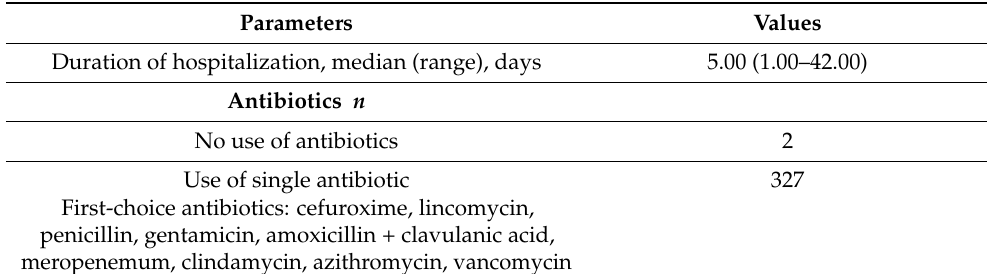
Table 2. Detailed data related to hospital stay, implemented treatment, identified bacterial species, and